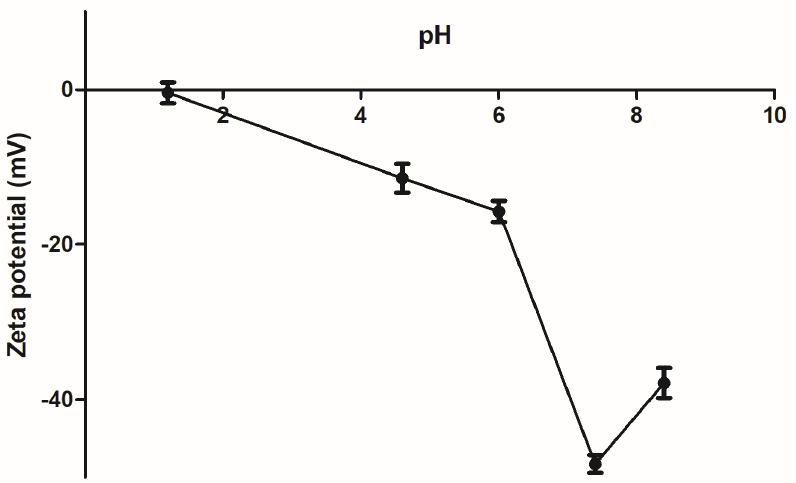
Figure 6. Zeta potential ( Z ) of polyacrylic acid/ Schizochytrium sp. (PAA/Schizo) microgels was evaluated at different pH values at 25 ◦ C. Data shown is the mean of three independent measure- ments ± standard deviation